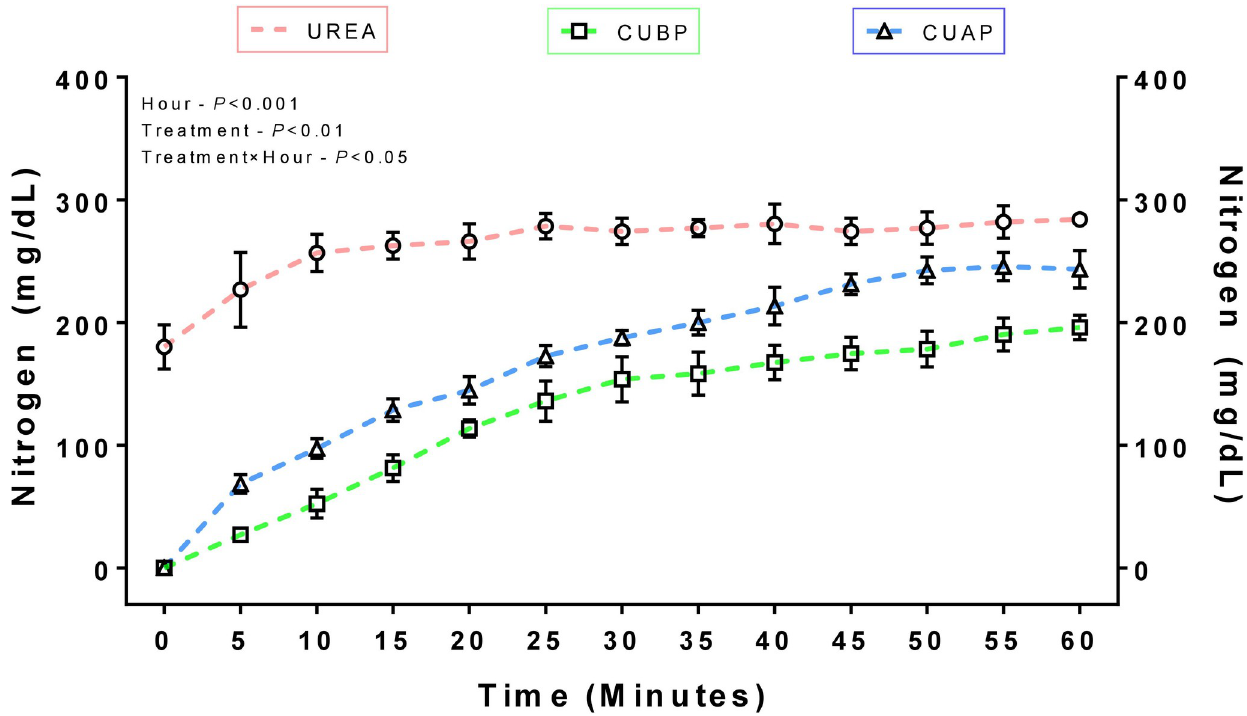
Fig 1. Nitrogen release from coated SRU products in vitro in distilled water compared to uncoated urea. Shown as means and standard errors of triplicate incubations (CUBP–Coated urea before processing, CUAP–Coated urea after processing).